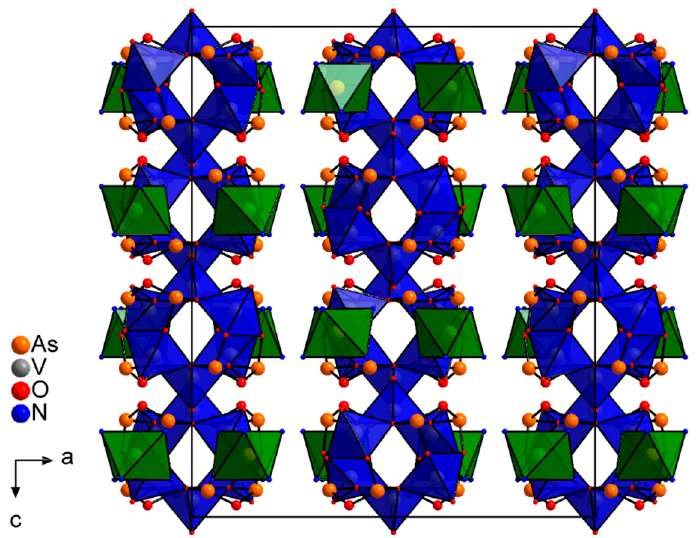
Figure 2. View of the arrangement of the constituents in the structure of the title compounds. C and H atoms are omitted for clarity.